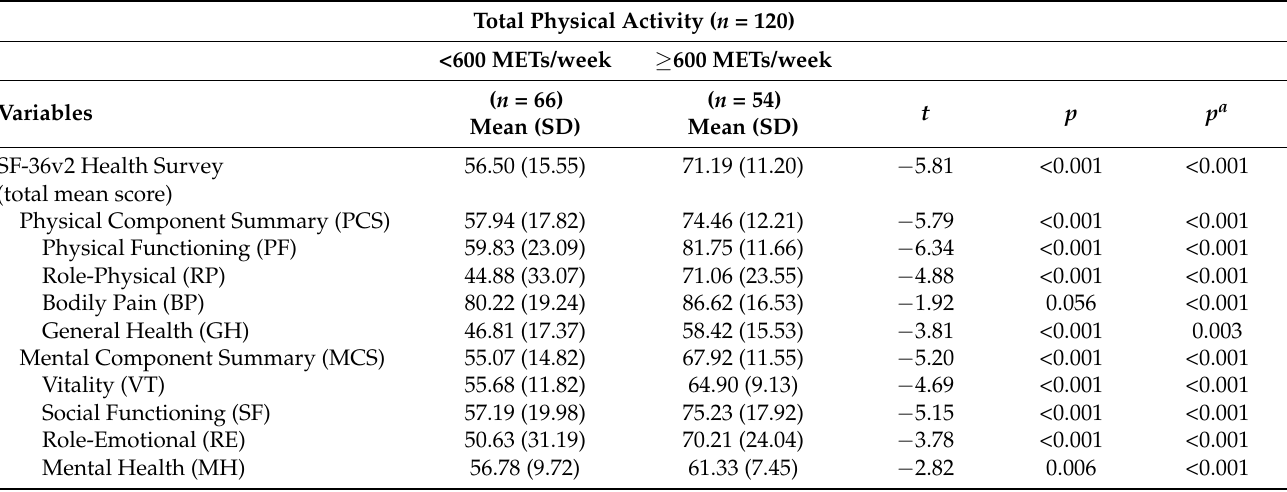
Table 4. Regression of the association between physical activity patterns and health-related quality of life of patients on hemodialysis ( n =